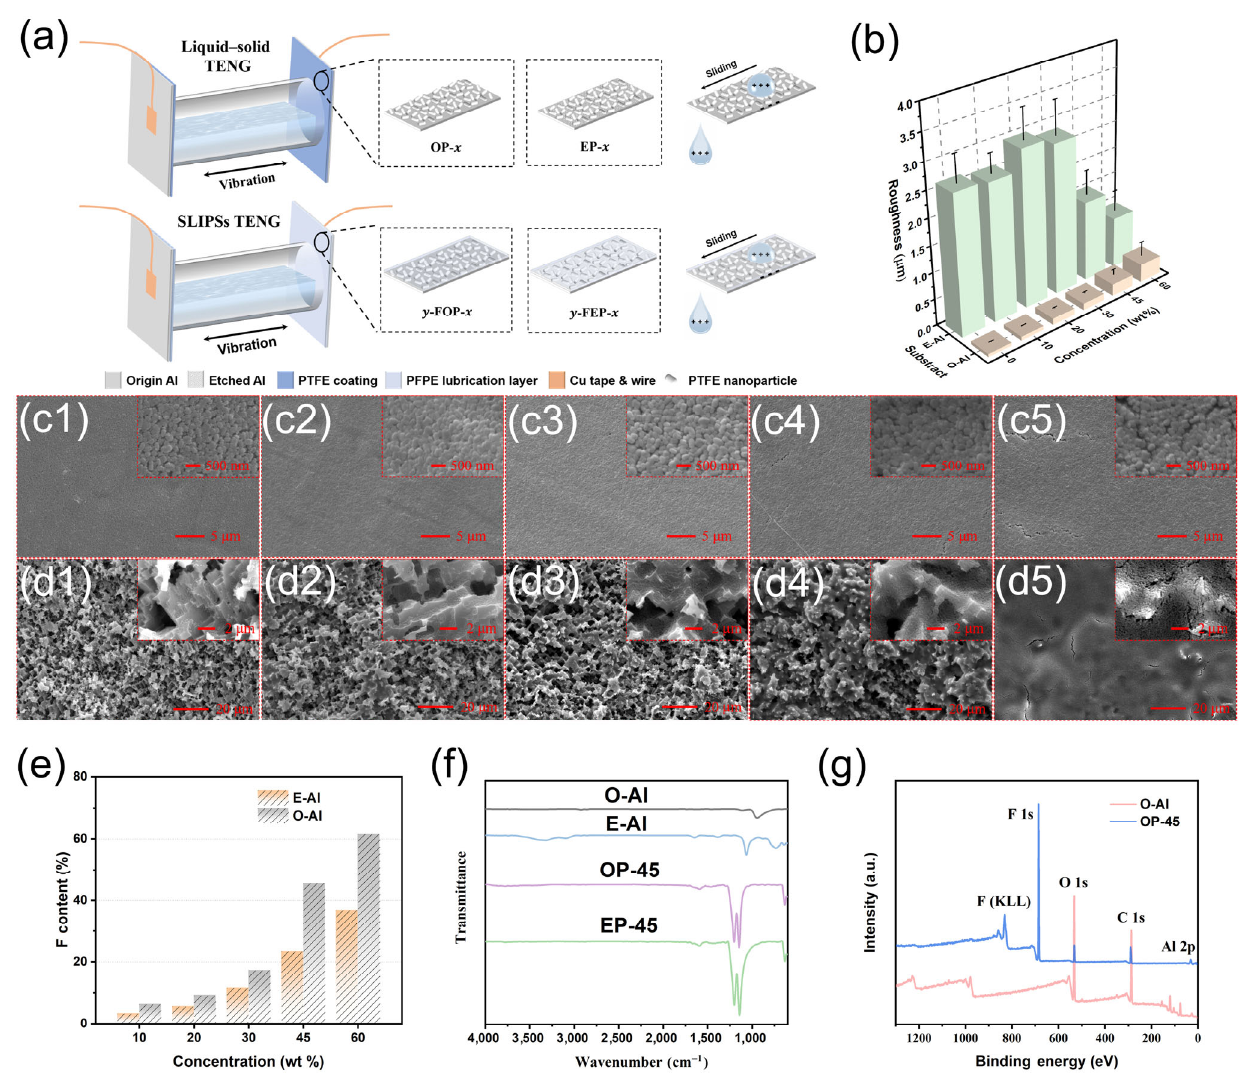
Fig. 1 Schematic of the TENG, the surface structure, and chemical constituents of different concentrations of PTFE dispersions coated O-Al and E-Al. (a) Schematic of the hydrophobic/SLIPSs TENG and the schematic of the morphology of different states Al sheets. (b) Roughness of OP- x and EP- x . (c1–c5) Nanostructure of OP- x , insets were the magnifying nanostructure. (d1–d5) Micro/nanostructure of EP- x , insets were the magnifying micro/nanostructure. (e) Percentage of element F in the total surface element content. (f) FTIR spectrum of O-Al, E-Al, OP-45, and EP-45. (g) XPS survey spectrum of O-Al and